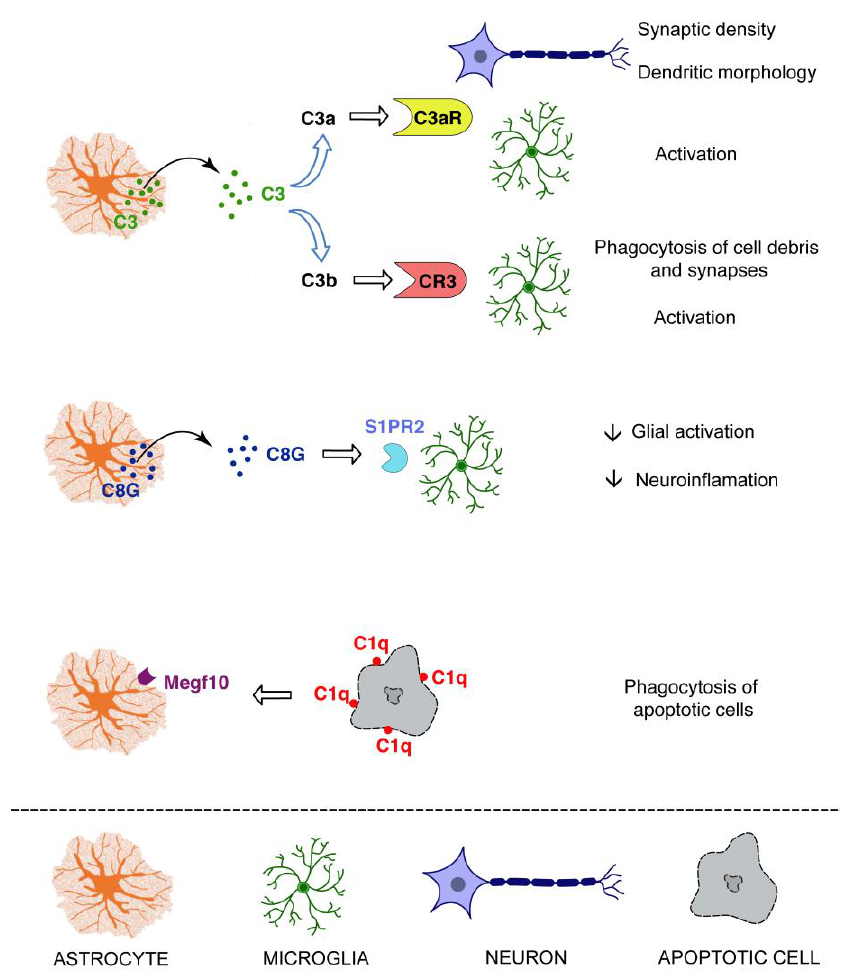
Figure 3. The complement system as an astrocyte effector. Astrocytes may exert some of their functions through the secretion of complement proteins, in particular C3 and the γ subunit of C8 (C8G), or through the phagocytosis of C1q coated targets. S1PR2: sphingosine-1-phosphate receptor 2.